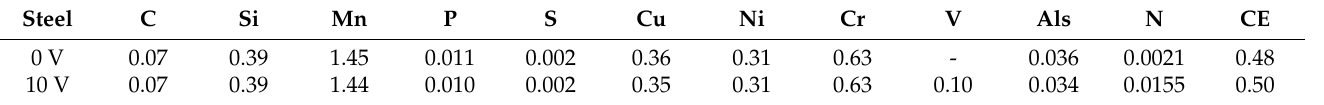
Table 1. Chemical composition and carbon equivalent values of tested steels (wt.%).